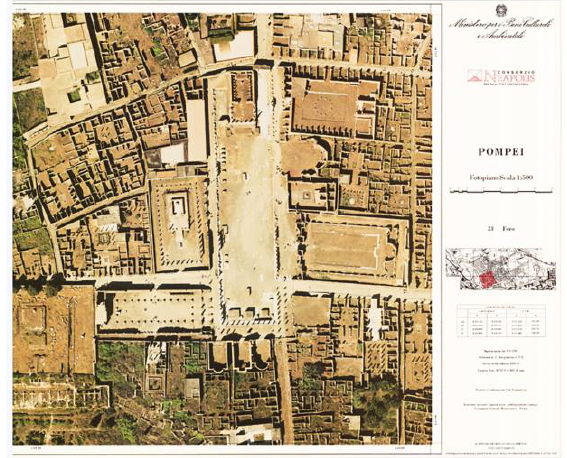
Figure 4. photopiano Pompei